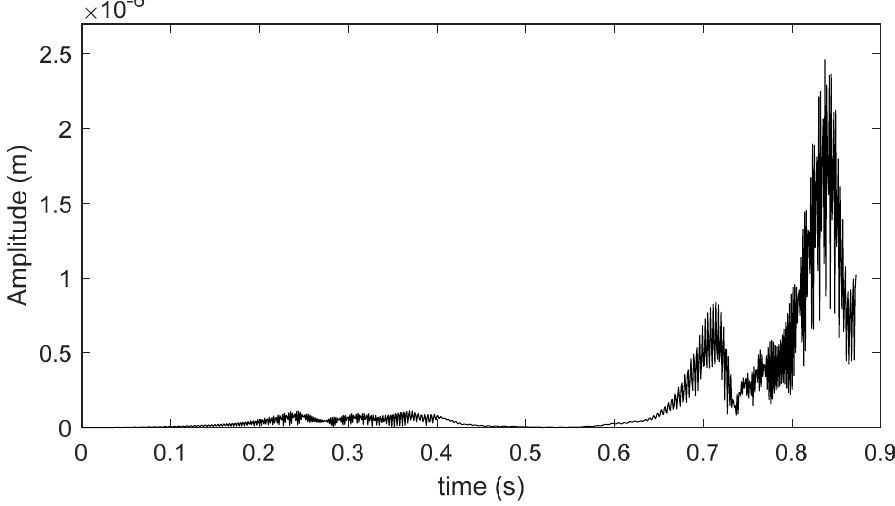
Figure 15. System vibratory response at node 4 with a linear ramp excitation with acceleration of 6000 rad / s 2